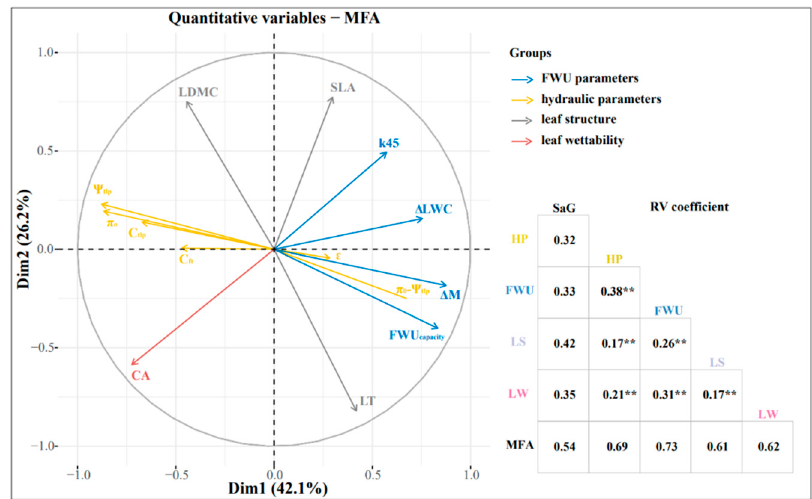
Figure 7. Multivariate factor analysis and correlation analysis of six plants’ FWU parameters, leaf structure, and hydraulic parameters. Leaf structure (LS) includes LDMC and LT; FWU parameters (FWU) include Δ M, Δ LWC, FWU capacity , and k 45 ; hydraulic parameters (HP) include Ψ tlp , π 0 , ε , and π 0 - Ψ tlp ; leaf wettability (LW) represents CA; SaG denotes species and gradients; k 45 represents the initial foliar water uptake rate; LDMC represents leaf dry matter content; SLA represents specific leaf area; C ft represents capacitance at full turgor; C tlp represents capacitance at turgor loss point; CA represents leaf contact angle. Blue, yellow, gray, and red represent FWU, HP, LS, and LW, re- spectively, ** p < 0.01.